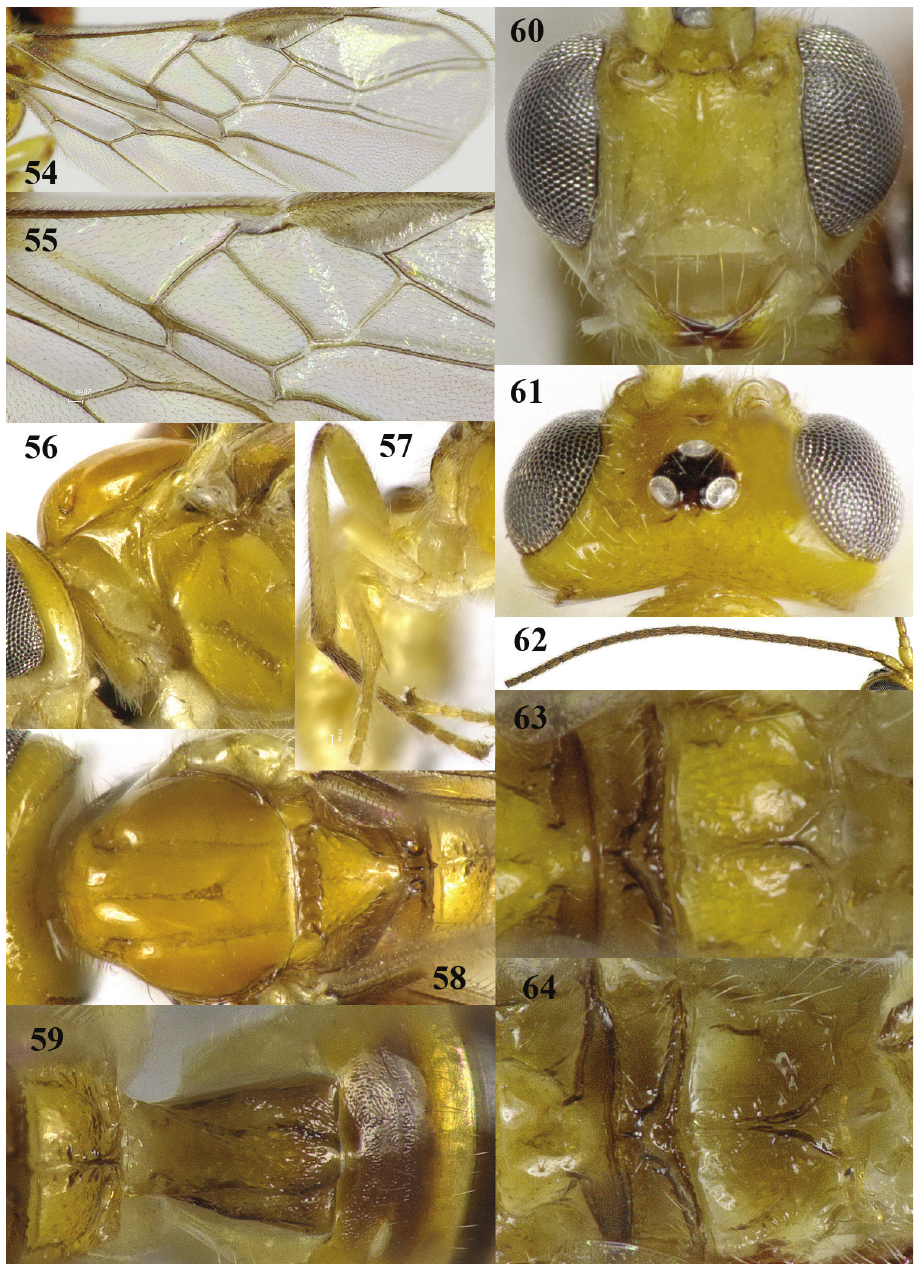
Figures 54–64. Psyttalia majocellata sp. n., ♂ paratype, but 64 of ♀ holotype. 54 wings 55 detail of middle third of fore wing 56 mesosoma lateral 57 hind leg 58 mesosoma dorsal 59 propodeum and first–third metasomal tergites dorsal 60 head anterior 61 head dorsal 62 antenna 63–64 metanotum and propodeum